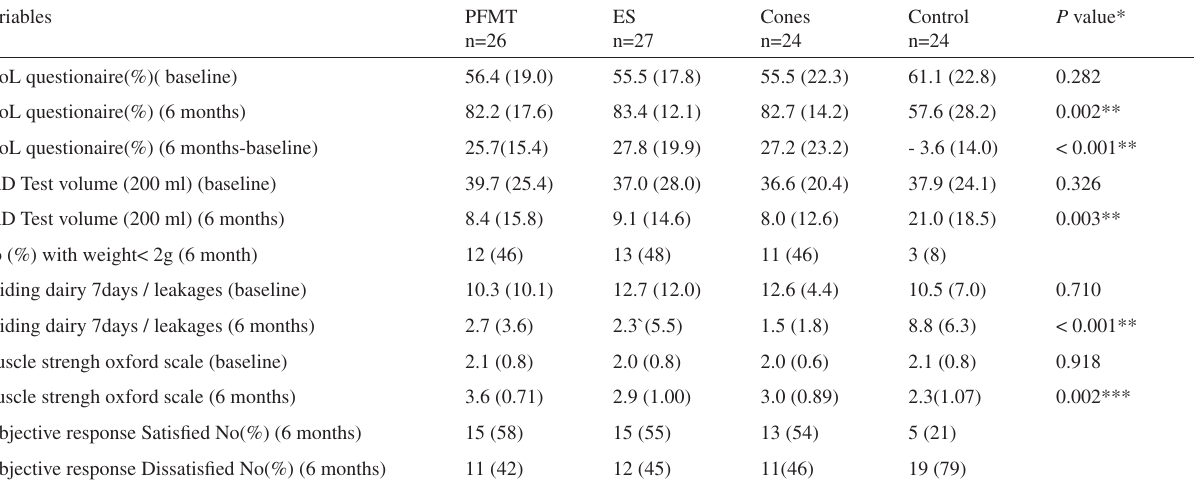
Table 2 - Outcome measure and muscle strengh at baseline and 6 months divided by treatment group Variables